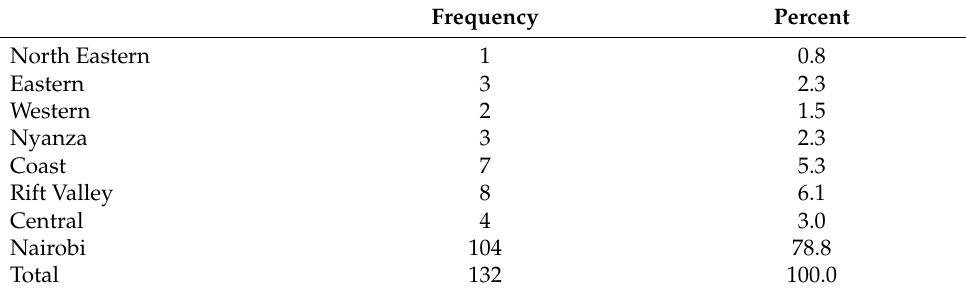
Table 5. Location of the respondents.